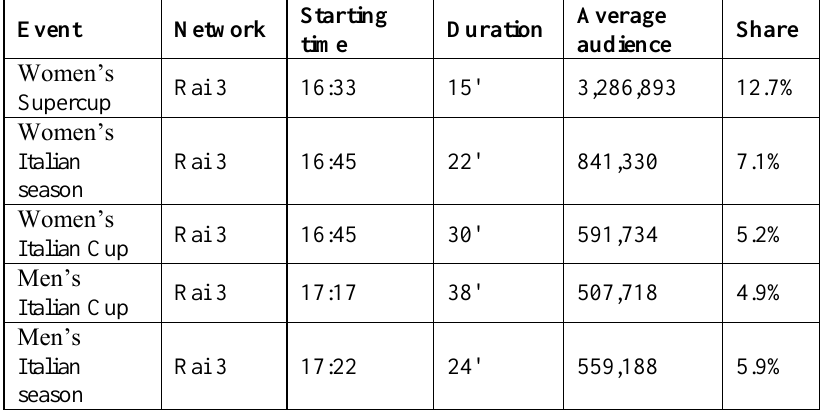
Figure 13: Volleyball TV Audiences (Italy)